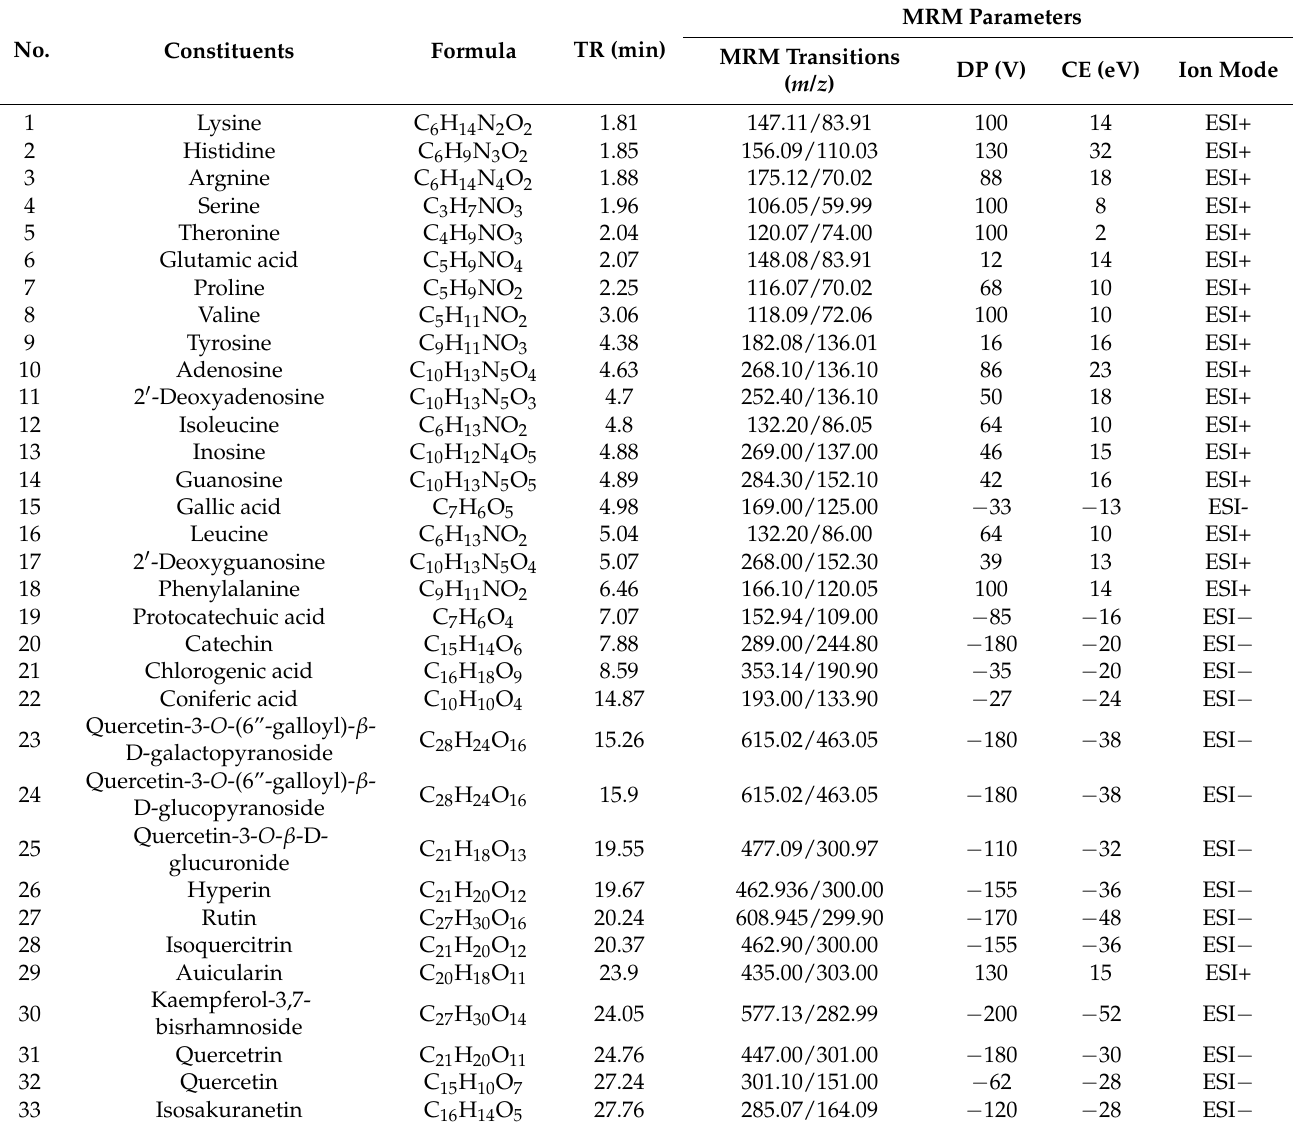
Table 1. Optimized mass spectrometric parameters for MRM of 33